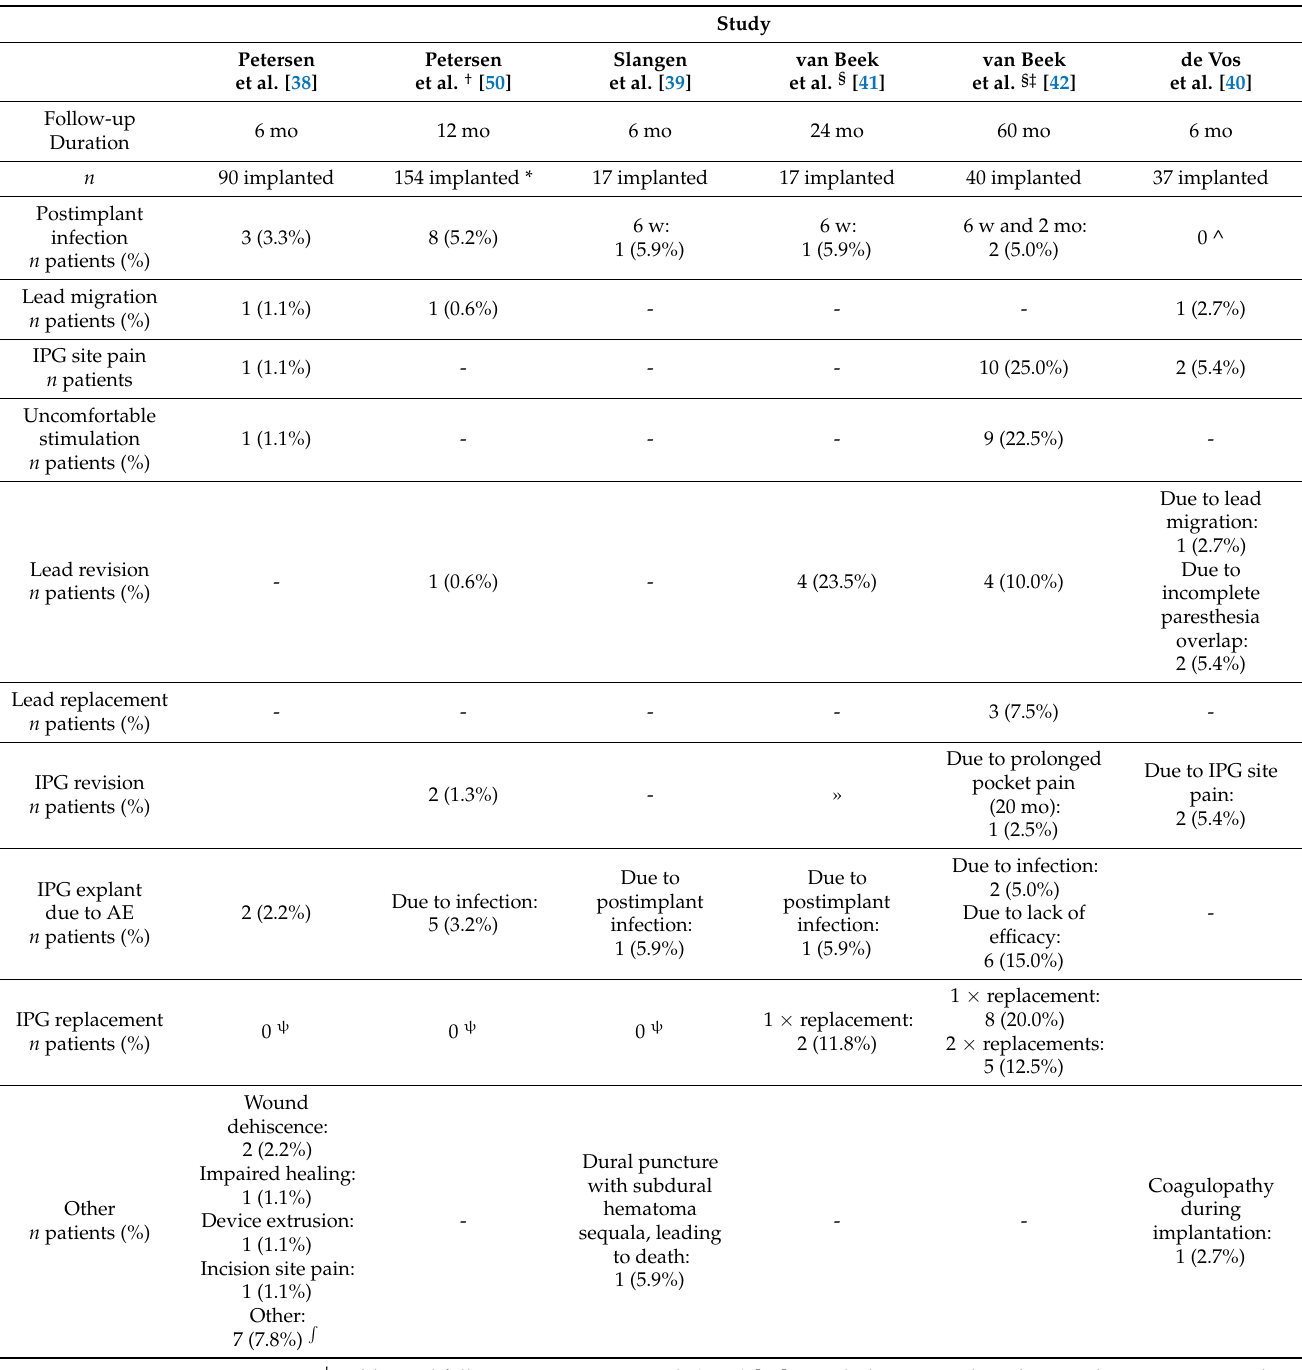
Table 5. Treatment-related adverse